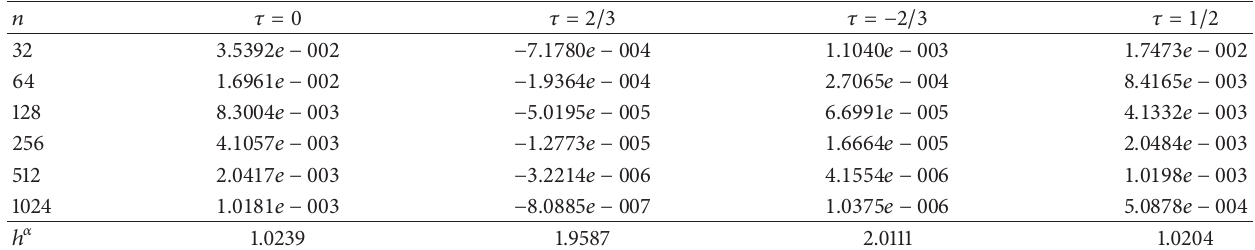
Table 1: Errors of the mod-trapezoidal rule with 𝑠 = 𝑥 [0𝑛/4] + (1 + 𝜏)ℎ/2 .